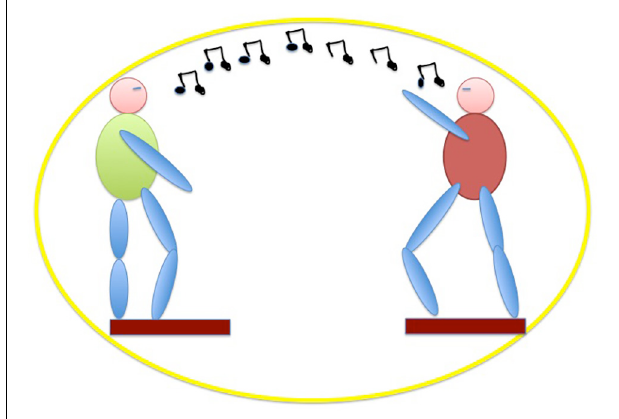
FIGURE 5 | The joint agency is strengthened whenever subsequent inter-onset-intervals are correctly predicted by the Bayesian system the singing couple builds